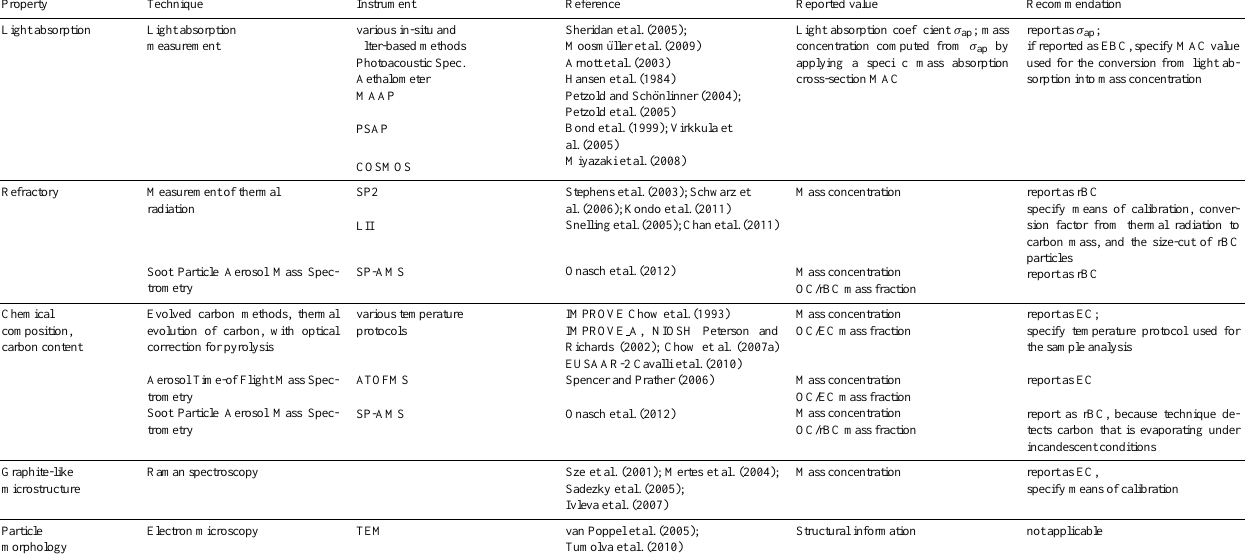
Table 2. Recommended terminology and related measurement techniques and